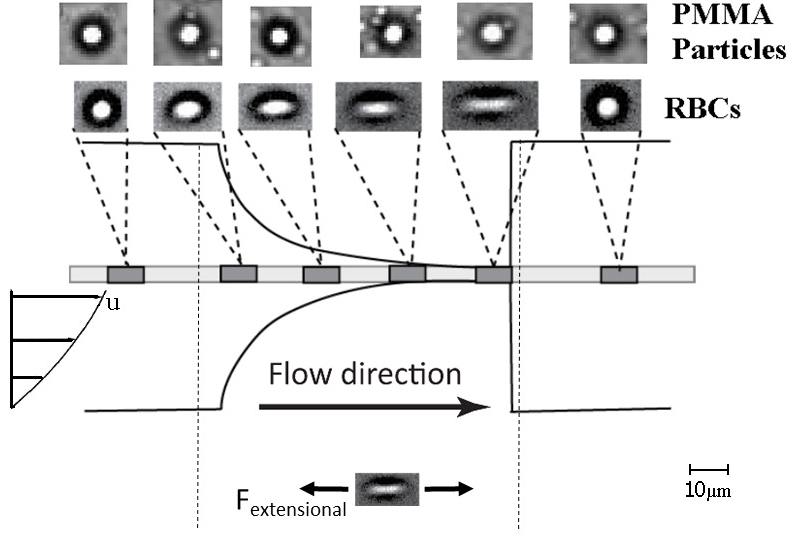
Figure 6. Illustration of the RBCs deformability through hyperbolic microchannel where F extensional represents the strong extensional force applied to the RBCs. The same forces was applied to the PMMA particles however without present any